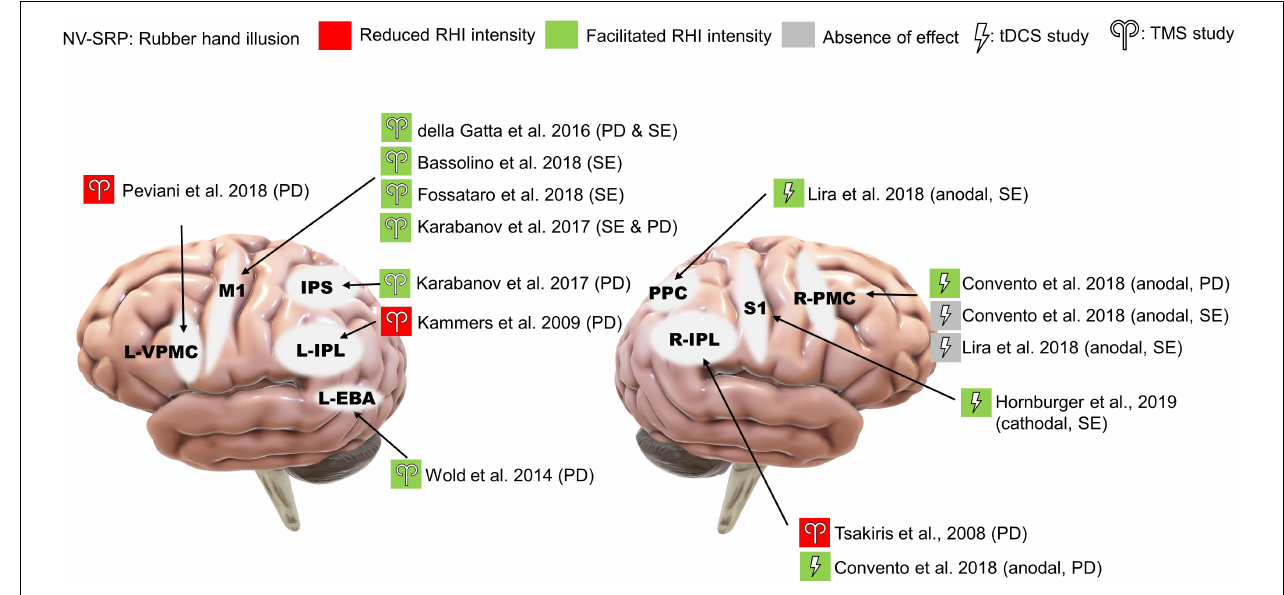
FIGURE 6 | Results of NV-SRP studies on RHI. PD, proprioceptive drift; SE, subjective embodiment of RHI.